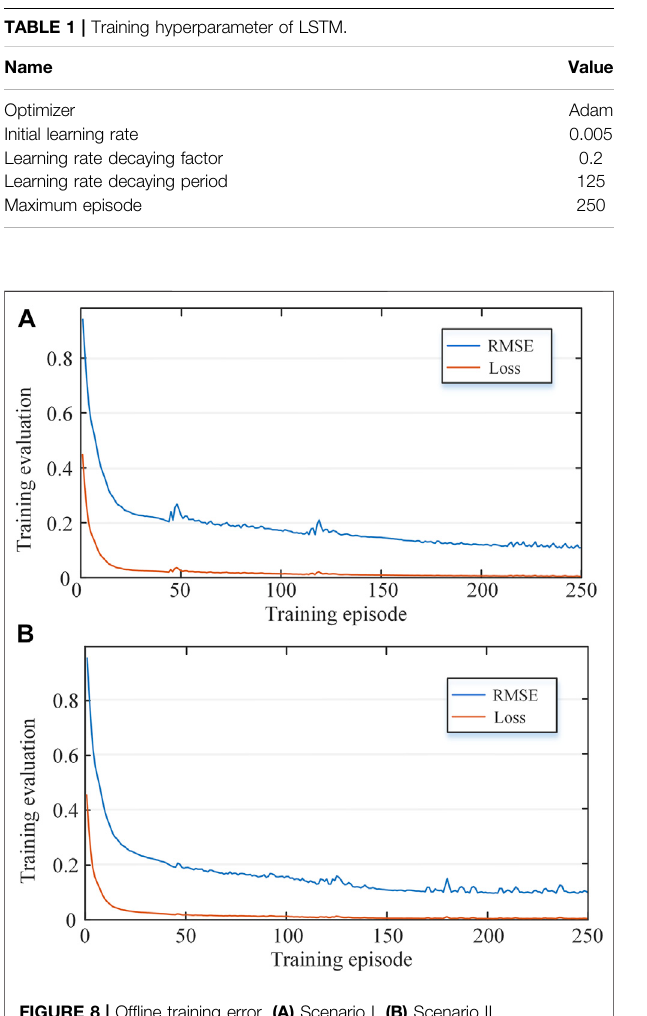
Frontiers in Energy Research |